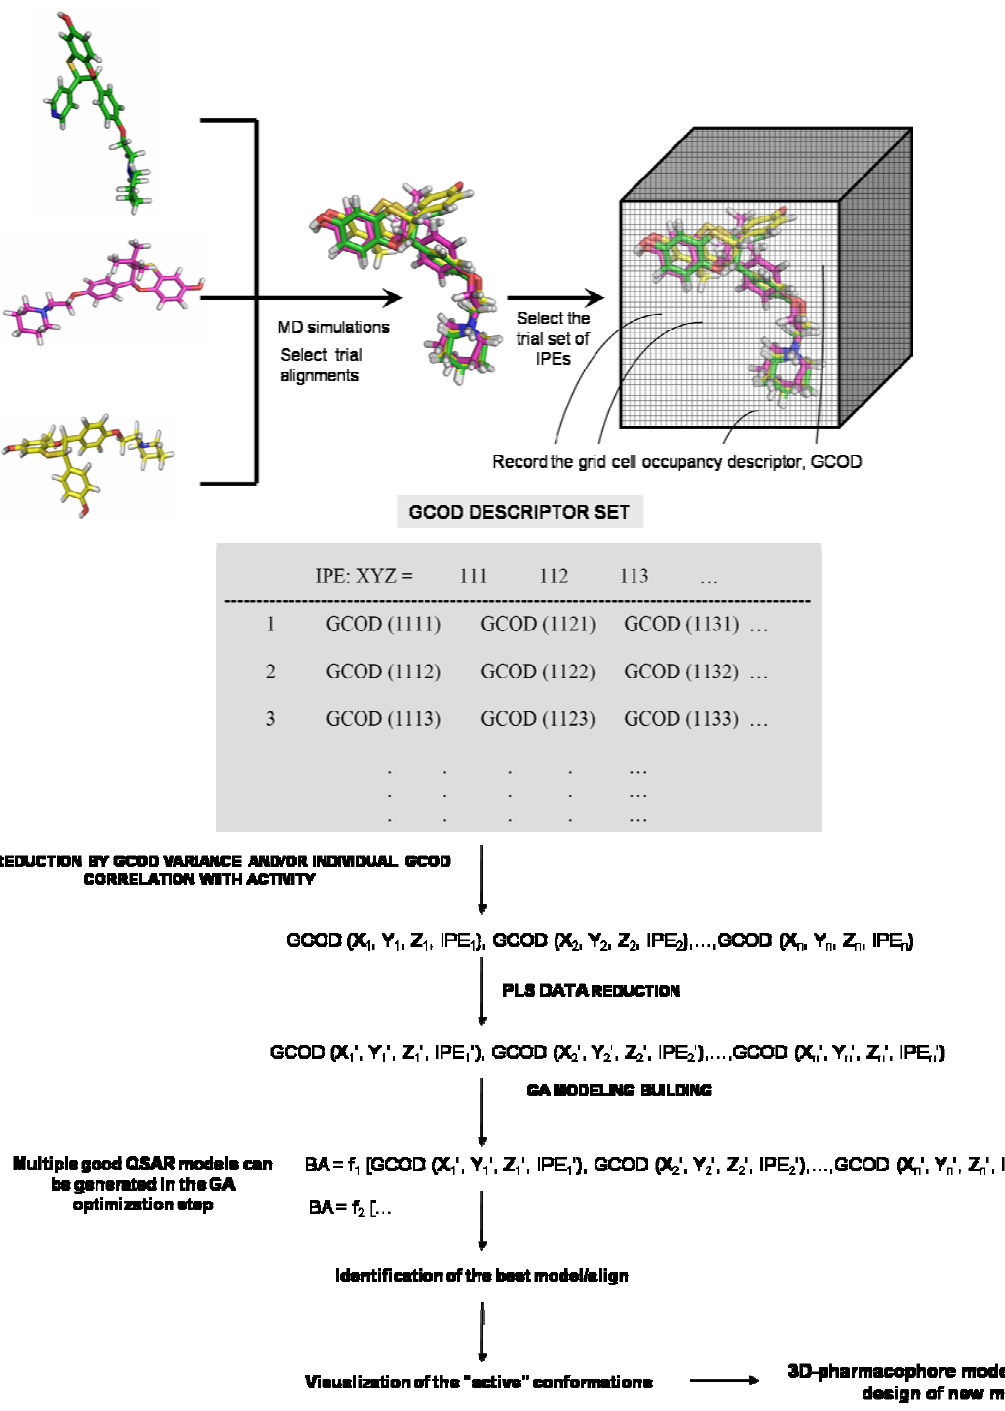
Figure 2. Schematic representation of the 4D-QSAR steps for the generation of